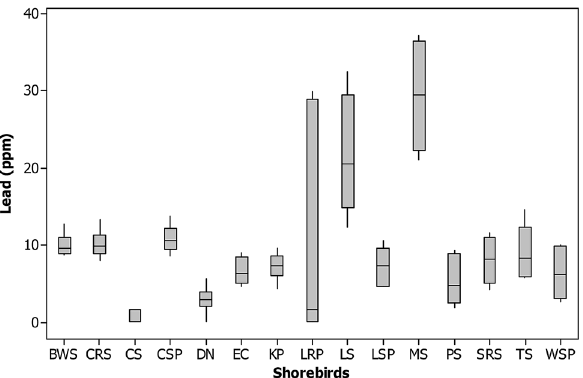
Figure 6. Box plot showing the concentration of lead (ppm) recorded in different shorebird species at Point Calimere Wildlie Sanctuary, Kodikkarai and Pichavaram Mangrove Forest, Pichavaram, east coast of Tamil Nadu,